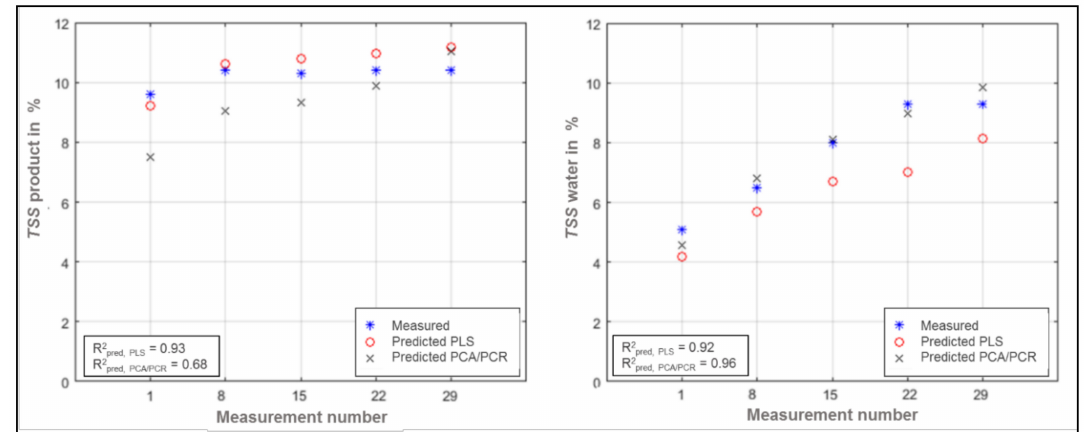
Figure 6. TSS measured and predicted for product ( left ) and water ( right ) (PLS and PCA /